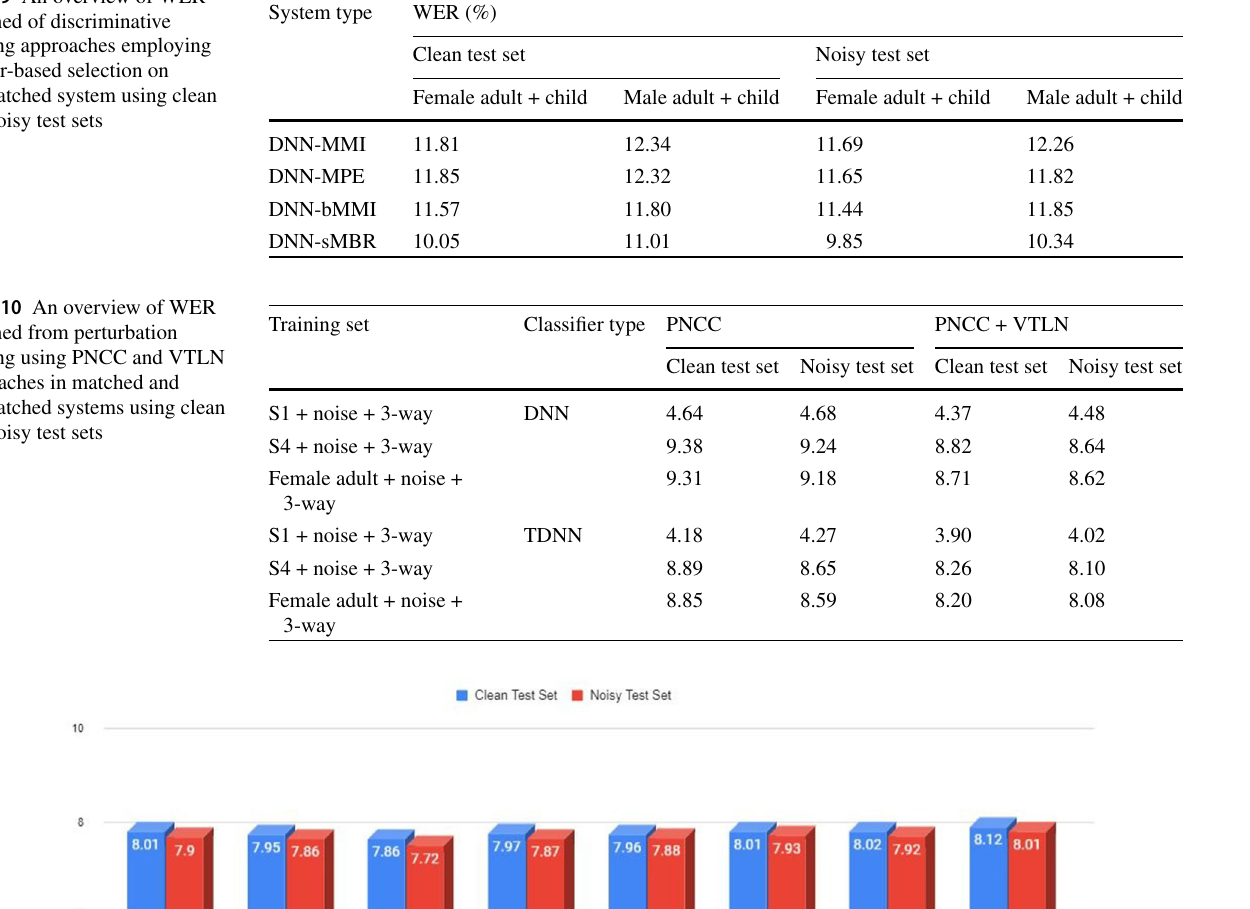
Table 9 An overview of WER obtained of discriminative training approaches employing gender-based selection on mismatched system using clean and noisy test sets